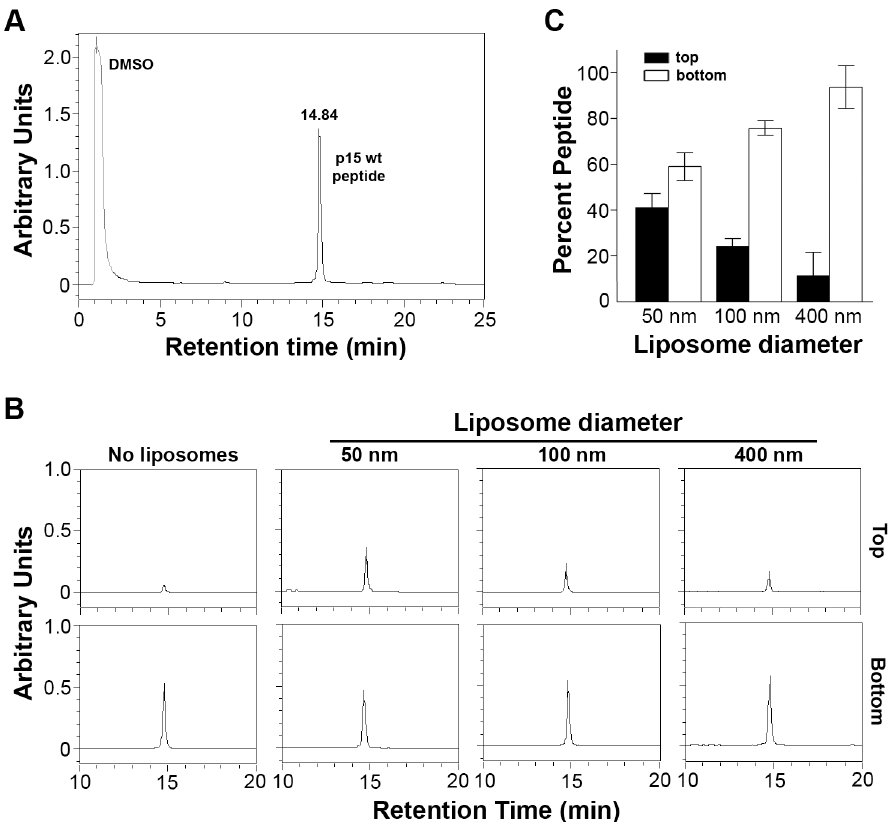
Fig 4. The p15HPpep peptide preferentially partitions into highly curved membranes. (A) Purified wt p15HPpep dissolved in DMSO was resolved by reverse-phase HPLC using a water:acetonitrile gradient and eluted with the indicated retention time. The chromatogram presents the area under the peaks in arbitrary units of absorbance at 215 nm. (B) The wt p15HPpep was mixed with liposomes (1:1:1 DOPC:DOPE: cholesterol) of the indicated diameters at a fixed peptide:lipid molar ratio (1:500), and liposomes were separated from free peptide by flotation on sucrose gradients. The peptides present in the top liposome and bottom free peptide fractions were detected by HPLC. Chromatograms from a representative experiment are shown in arbitrary fluorescence units at the same scale for the retention time corresponding to the p15HPpep. The No Liposome chromatograms are for p15HPpep treated exactly as above but incubated in the absence of liposomes before sucrose gradient fractionation; the chromatogram indicates the low level of free peptide contaminating the top sucrose fraction. (C) The liposome (top) and free peptide (bottom) sucrose fractions were analyzed by HPLC as in panel B, and the relative peptide concentration in each fraction quantified by integrating the area under the peak in the HPLC chromatograms. Percent peptide = Area Top / Total Area Top +Bottom . Bars represent the mean SEM of three